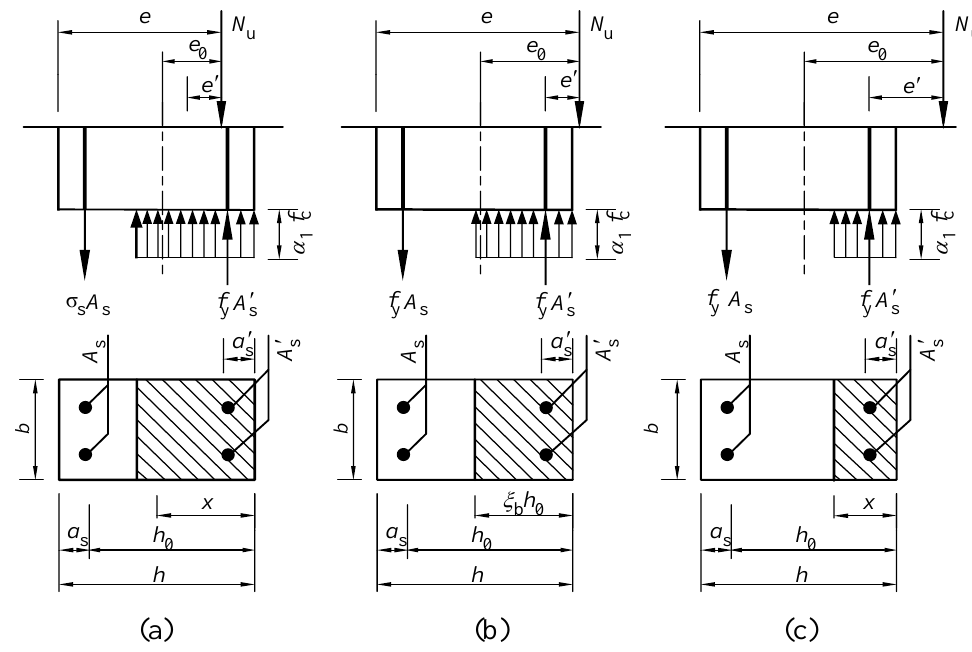
Figure 9. Calculation diagram for stainless-steel-reinforced concrete (SSRC) columns subjected to eccentric load: ( a ) small eccentricity, ( b ) limiting eccentricity, and ( c ) large eccentricity.